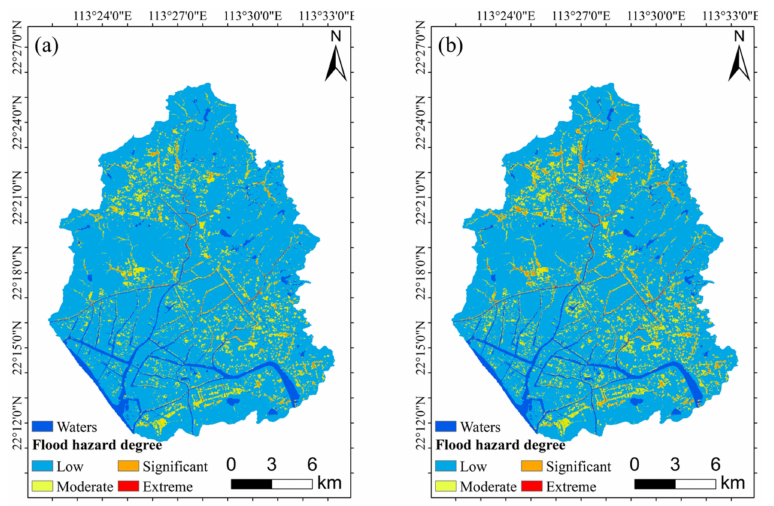
Figure 9. Spatial distribution of flood hazard zonation based on HR values. ( a ) 50-year return period; ( b ) 100-year return